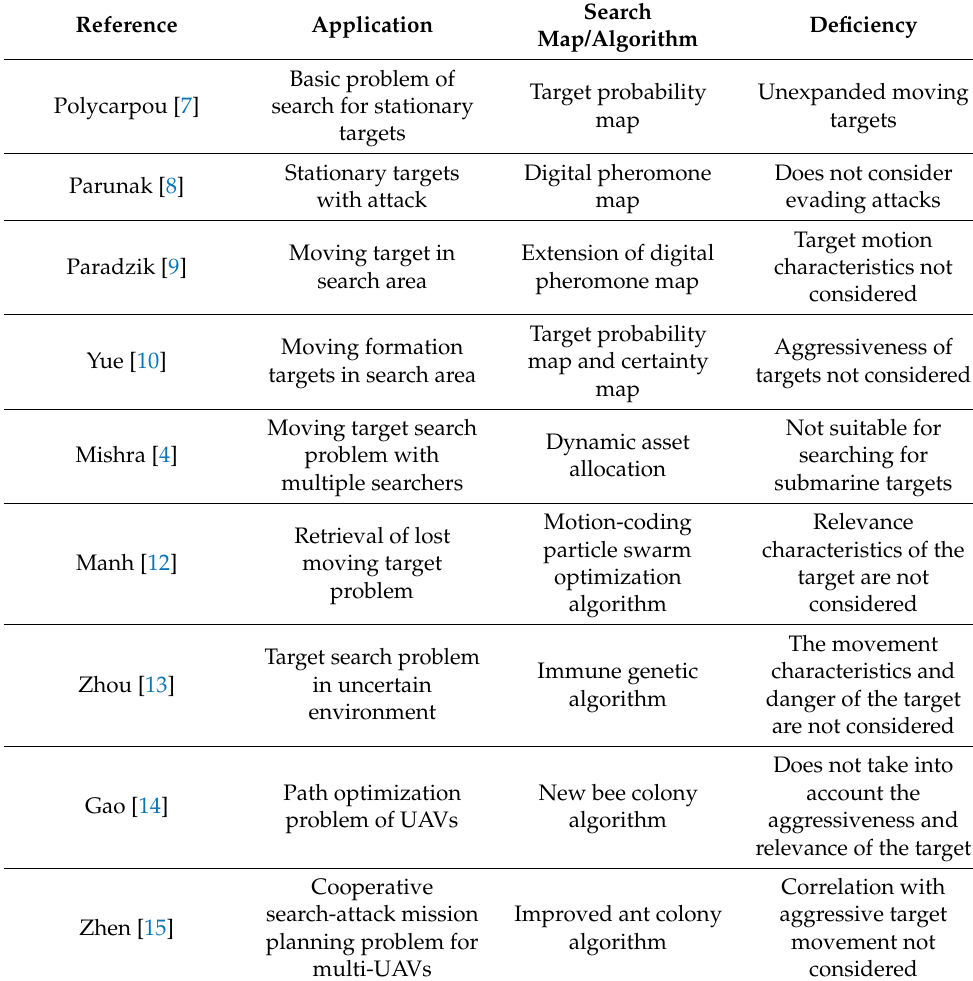
Table 1. Related